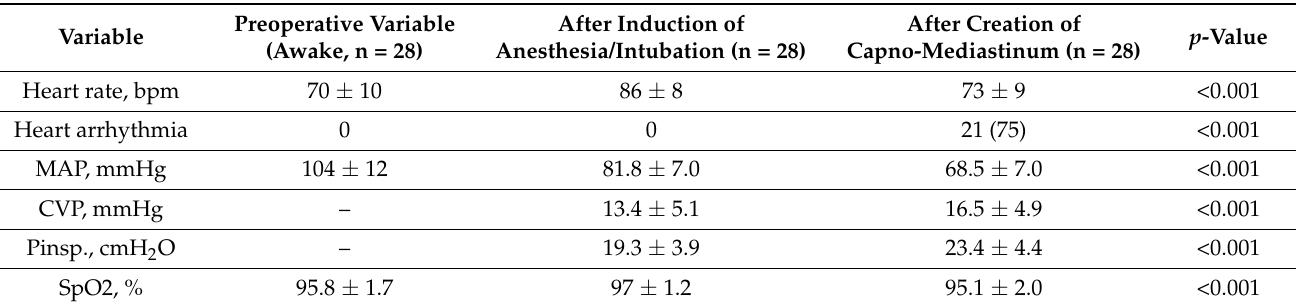
Table 3. Intraoperative hemodynamic and pulmonary changes.